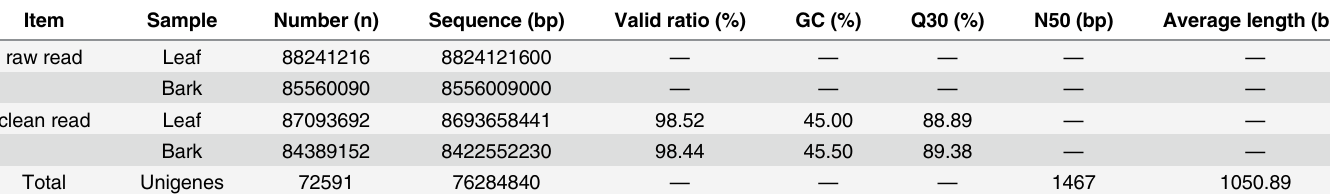
Table 1. Statistic of sequencing and de novo assembling of transcriptome in W . ugandensis .